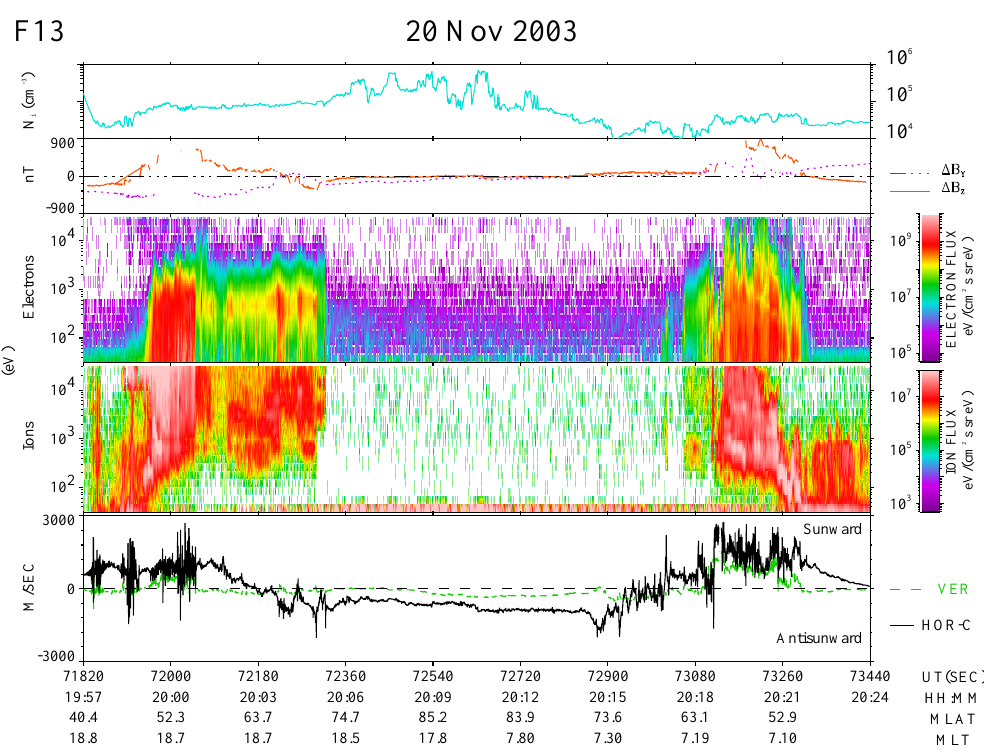
Figure 6. Density, magnetic field, electron and ion fluxes, and drift velocities measured by DMSP-F13 satellite on 20 November 2003. Note the density enhancements observed within the polar cap after 20:06UT.